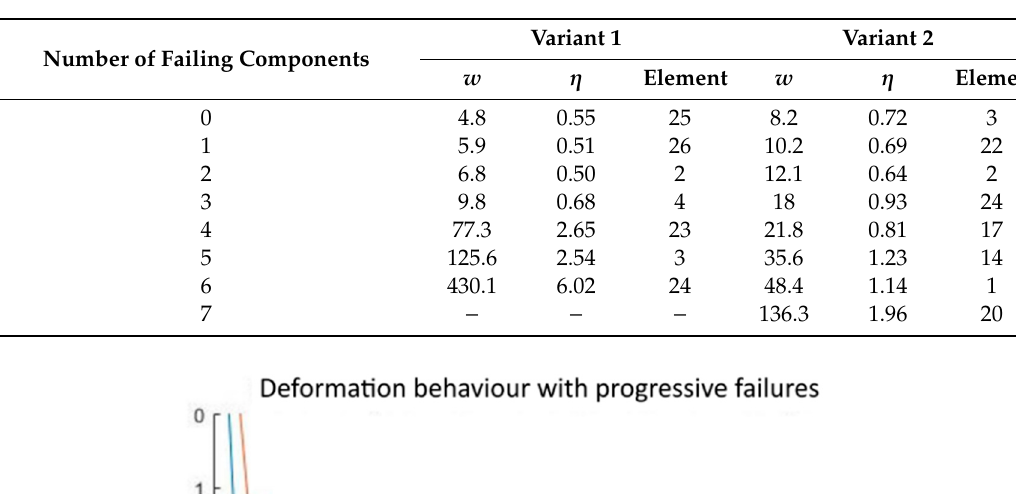
Table 1. System deformations ( w ) [mm] and utilization ratios ( η ) [–] during successive failure of the truss system components; element i.d. numbers according to Figure 4.